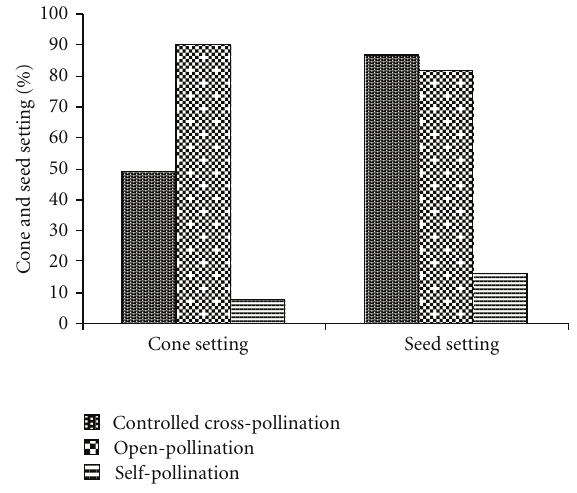
Figure 3: Cone and seed setting after controlled